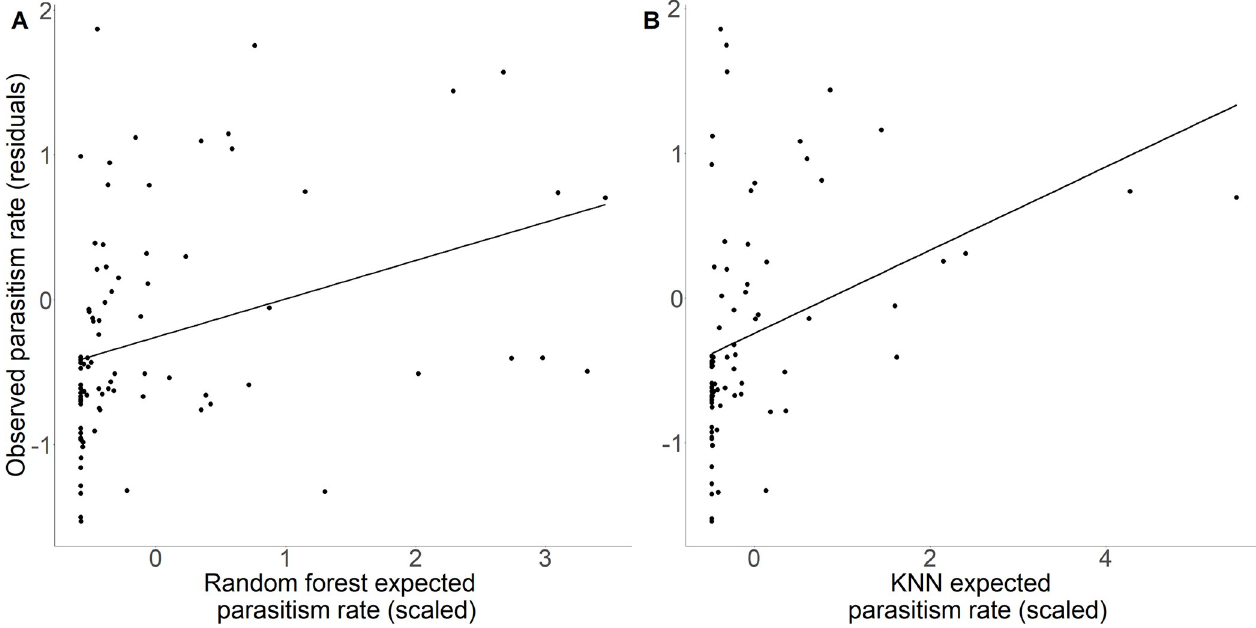
Fig 4. Predictions of observed parasitism rate. (A) Random-forest- and (B) KNN- expected parasitism rate both significantly predicted observed parasitism rate. Residuals of the best-fitting model excluding the predictor on the x axis are plotted. Each point represents a host species within a site in the second-time step ( t+1 ) test sites. Three and four outliers, respectively, were removed from (A) and (B), though the results with the outliers included were qualitatively the same in both cases.